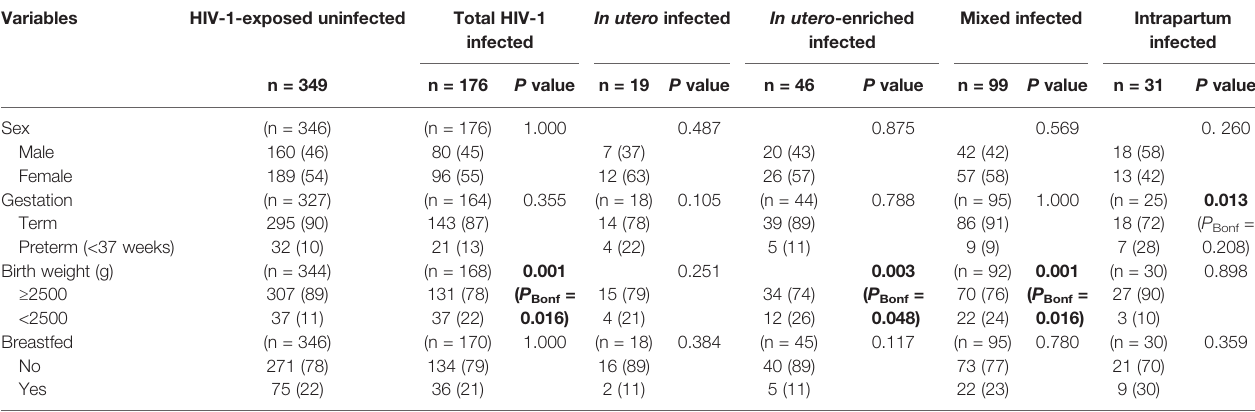
TABLE 1 | Demographic and clinical characteristics of perinatal HIV-1 acquisition